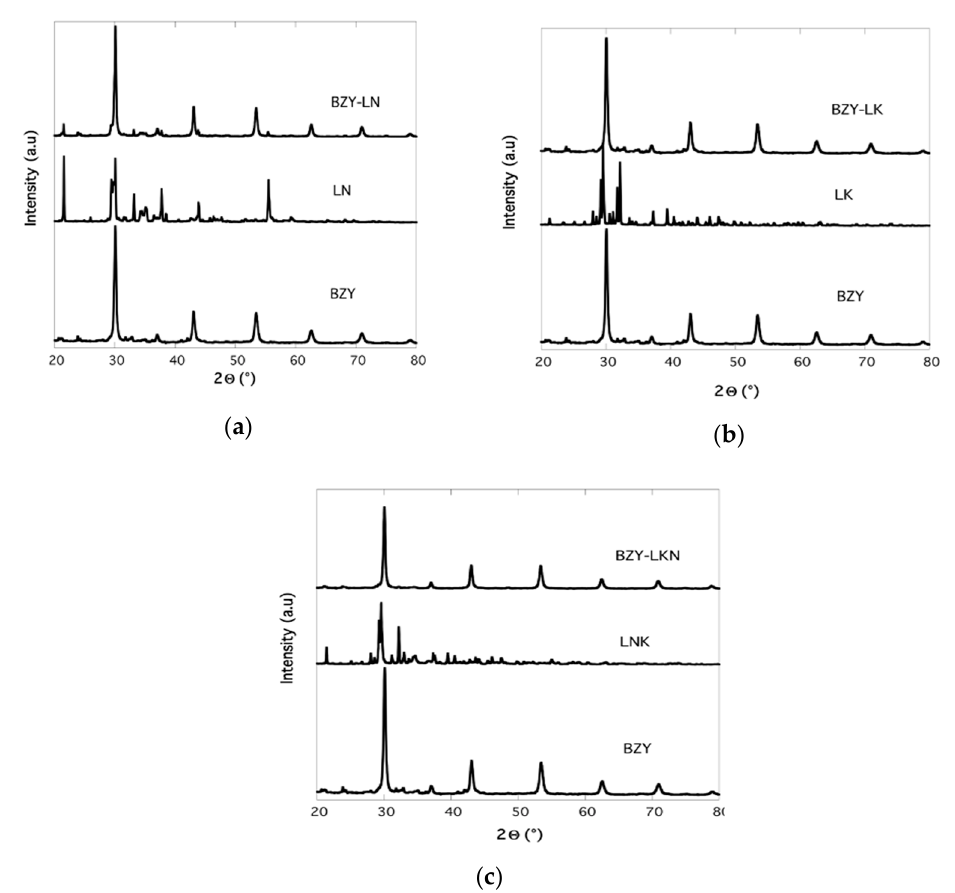
Figure 1. XRD patterns of BZY, alkali carbonates, and BZY – alkali carbonate composites. ( a ) BZY – LN; ( b ) BZY – LK; ( c ) BZY – LKN.